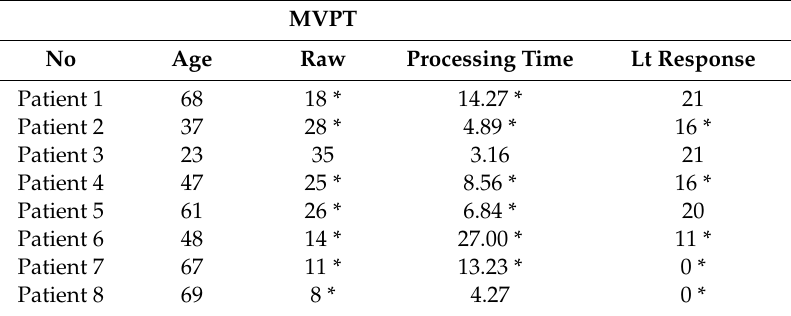
Table 3. Motor-free visual perception test (MVPT) results of eight patients.